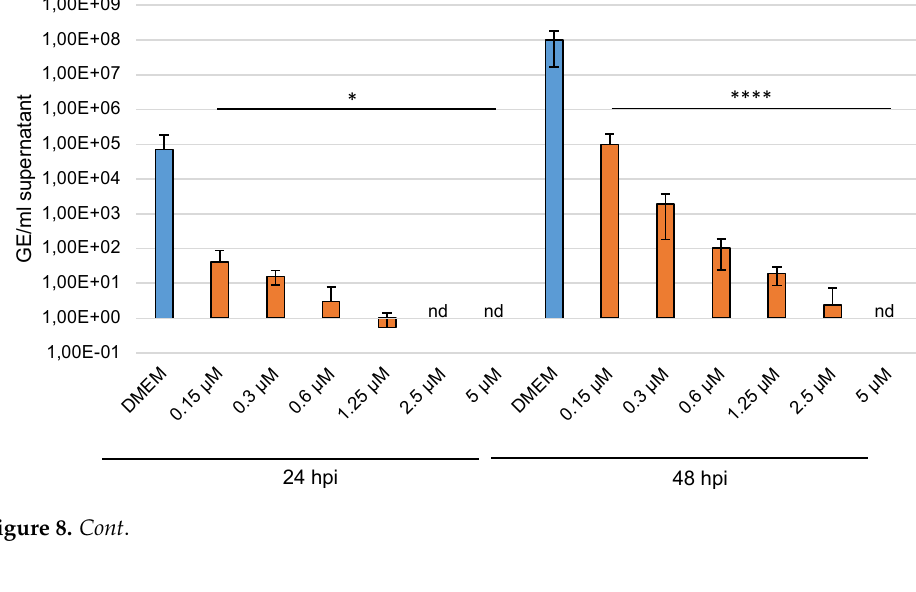
B Figure 8. Cont